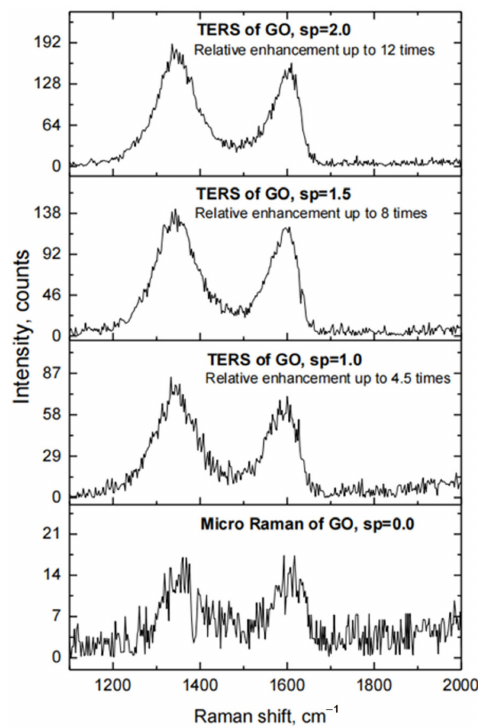
Figure 5. Raman spectra of GO, when Si probe coated with Au by thermal evaporation in the vacuum technique is in contact with the surface of Si substrate coated with a film of GO (TERS of GO at different values of set point (sp), sp = 1.0, 1.5 and 2.0), and when this probe is retracted from the surface of the substrate (MicroRaman of GO, sp =